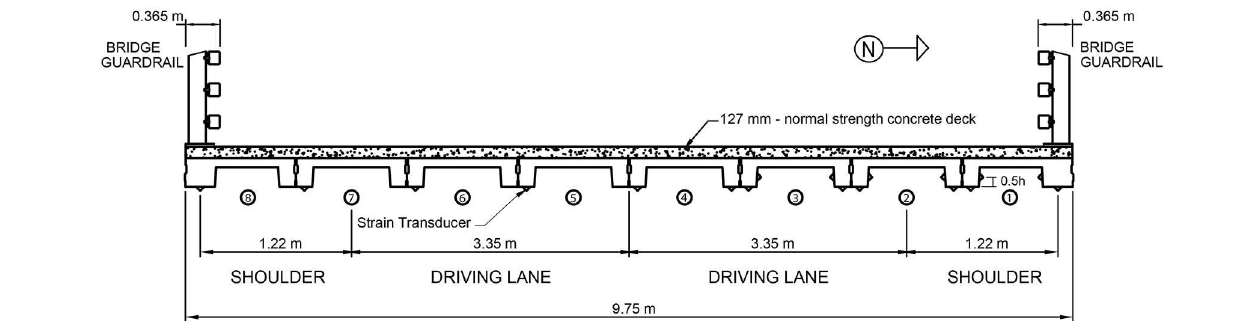
FIGURE 3 | Instrumentation locations at bridge